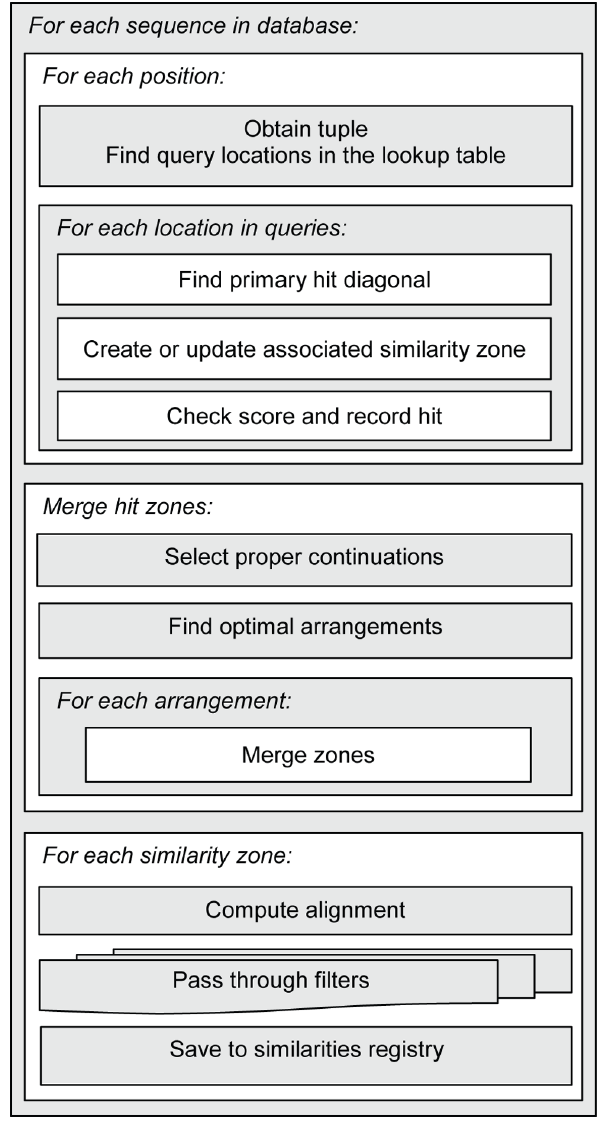
Figure 4. Block-scheme for the inner search loop. For each subject sequence, k-tuples starting from every position are looked up, and the match locations are recorded. The offset of the diagonal where the match appears is computed, and the associated diagonal control structure is updated with the location and the score of the match. On the accumulation stage, multiple neighboring primary hits are aggregated into Similarity Zones, reducing the number of items for processing. Such zones, in turn, may merge into a smaller number of larger aggregates.